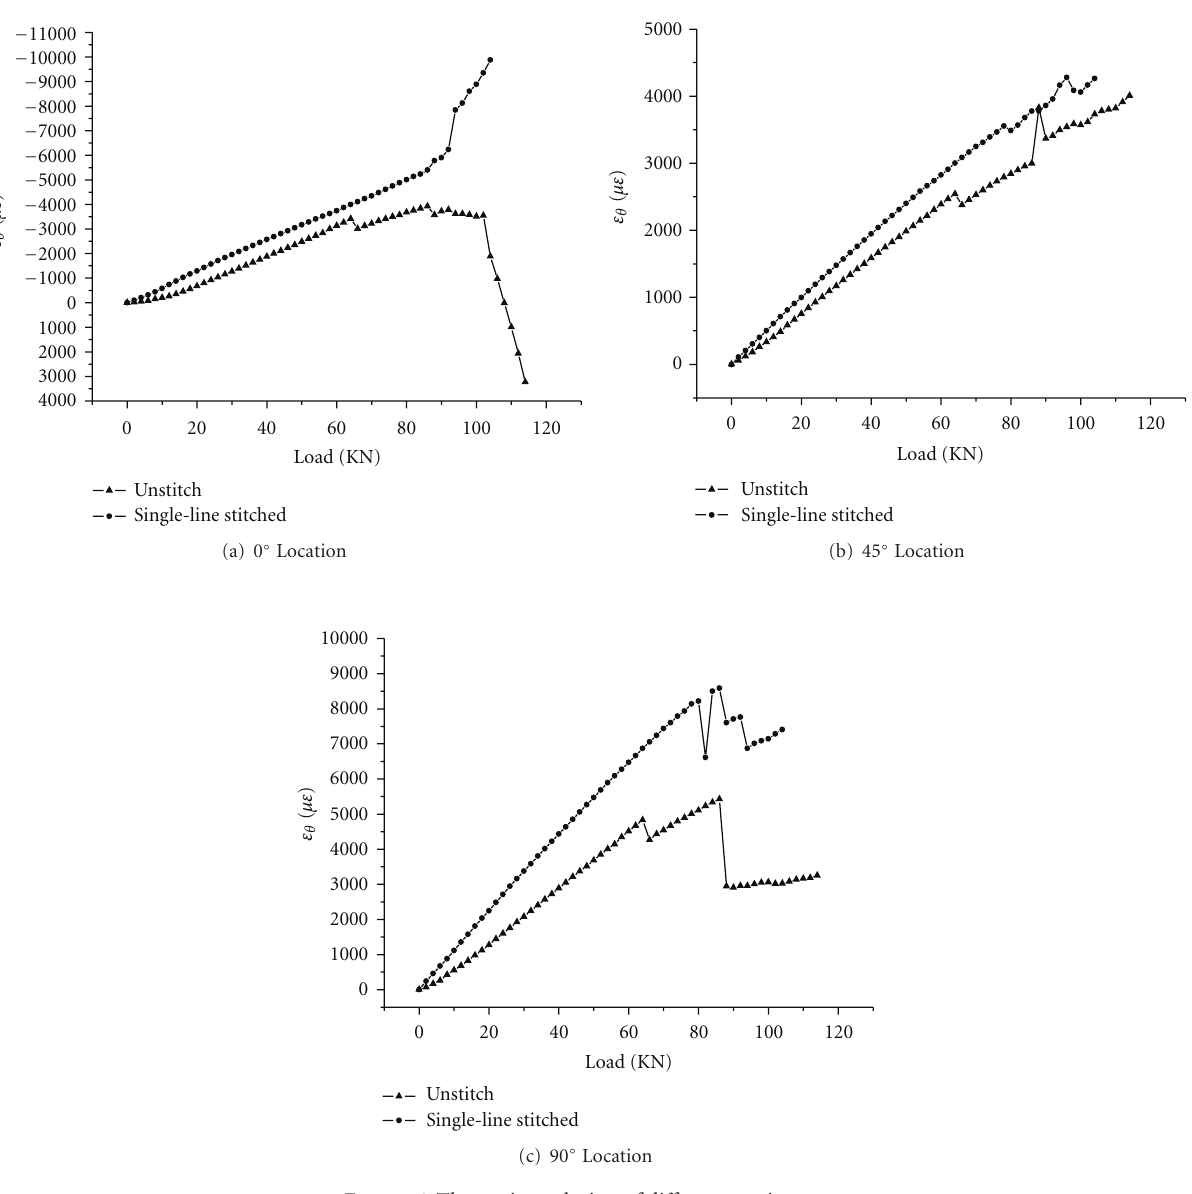
Figure 6: The strain evolution of di ff erent specimens.